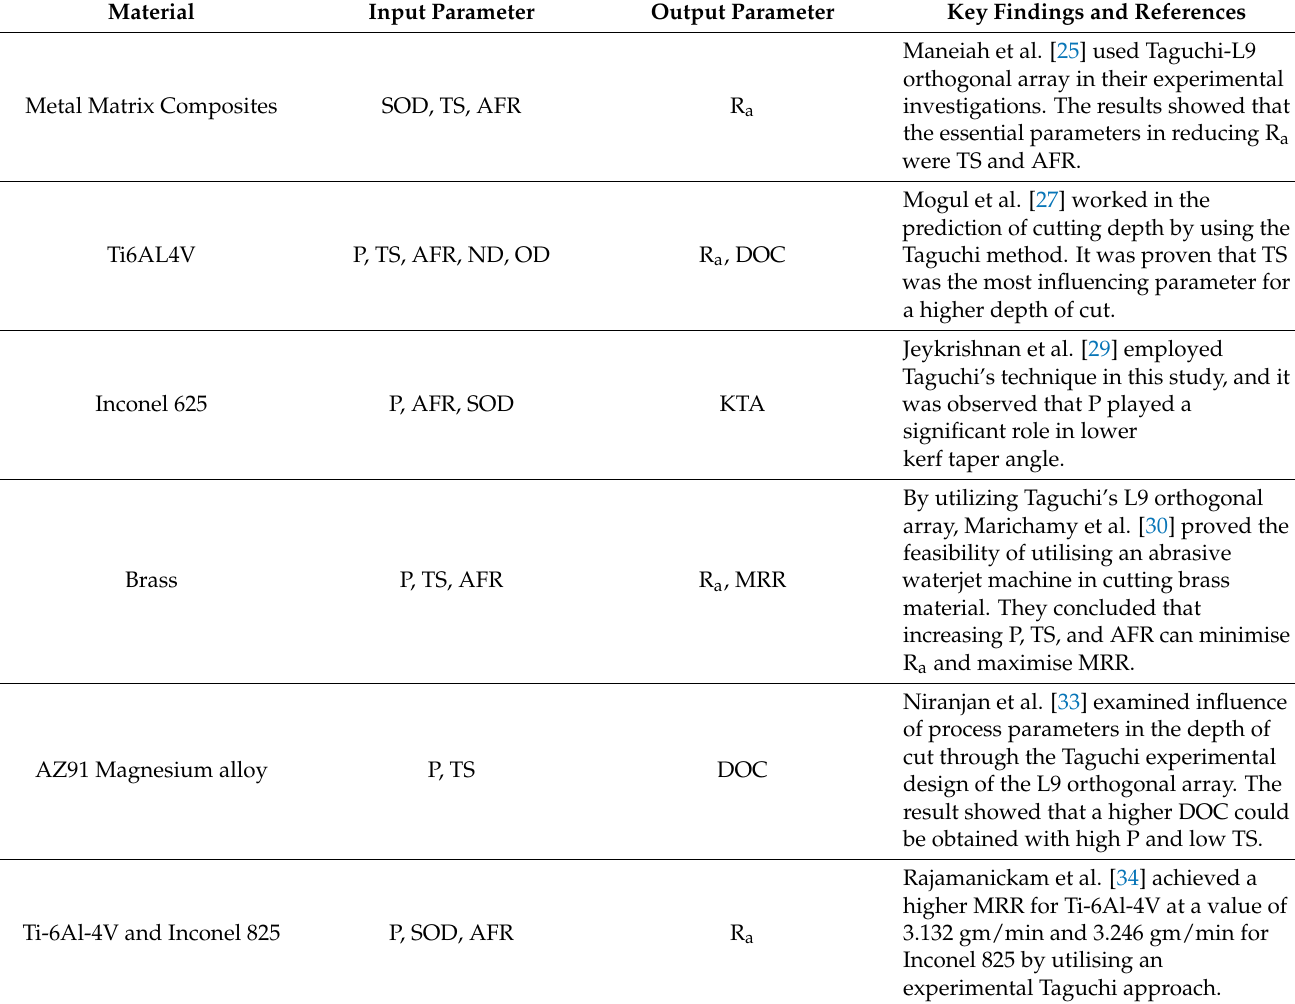
Table 9. Several studies (2018 to 2020) in AWJ cutting carried out through the Taguchi